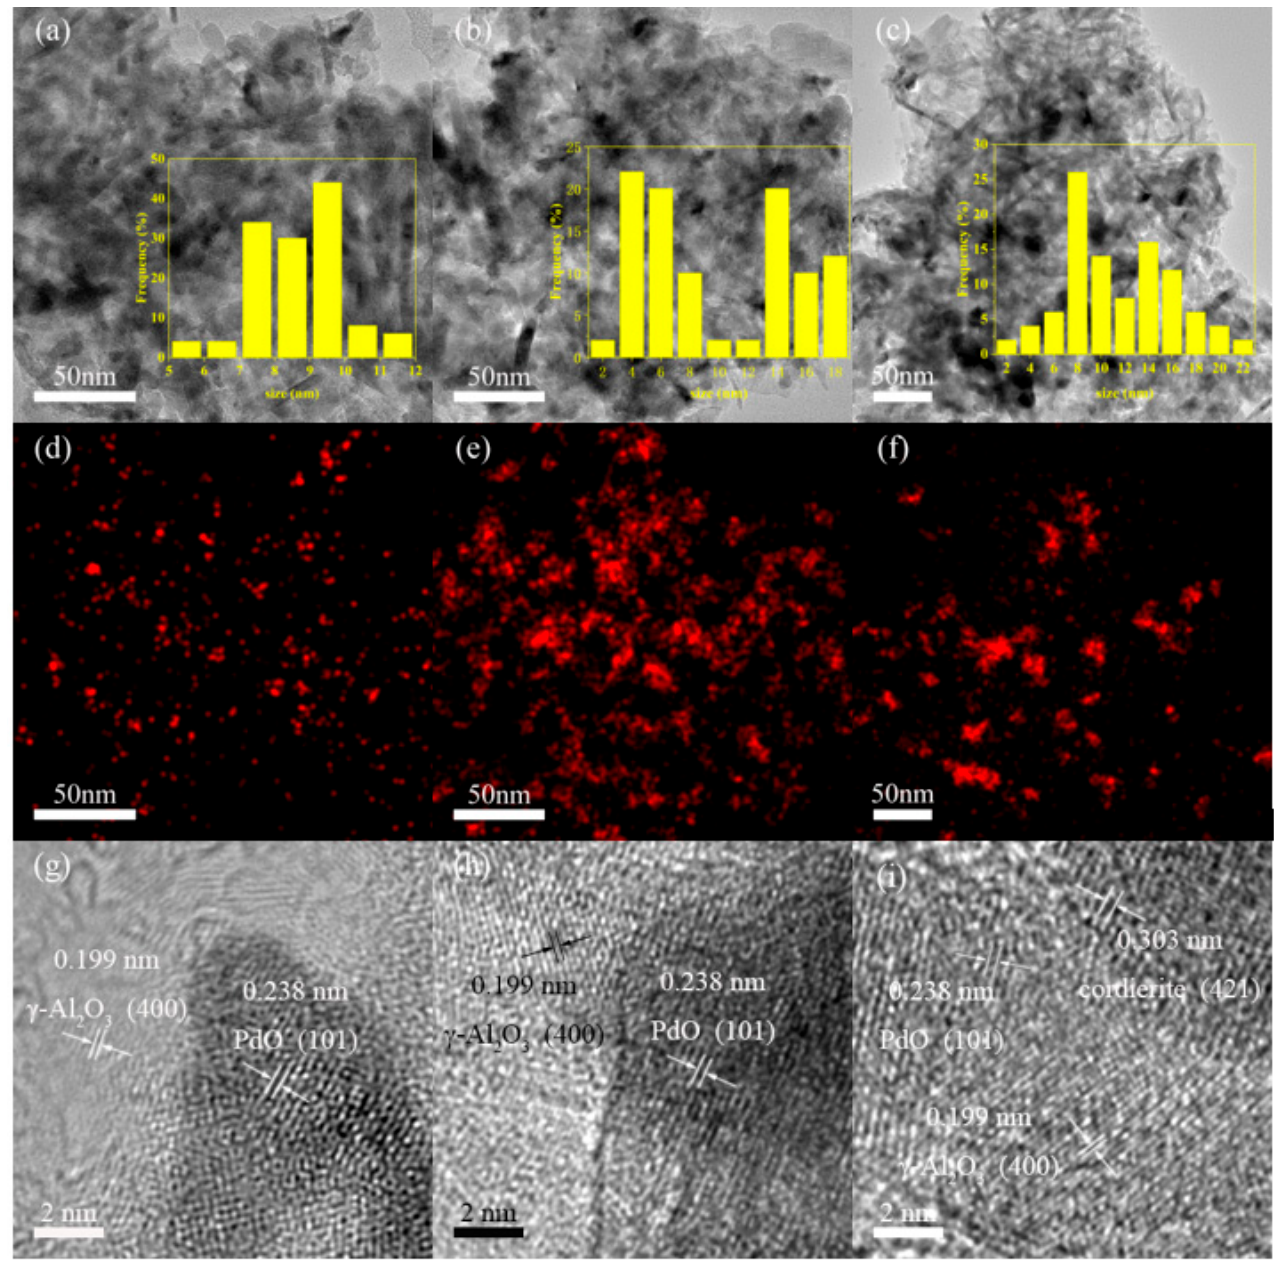
Figure 3. Transmission electron micrographs ( a – c ), Pd elemental maps ( d – f ) and High-resolution transmission electron micrographs ( g – i ) of Pd-1, Pd-2 and Pd-3.